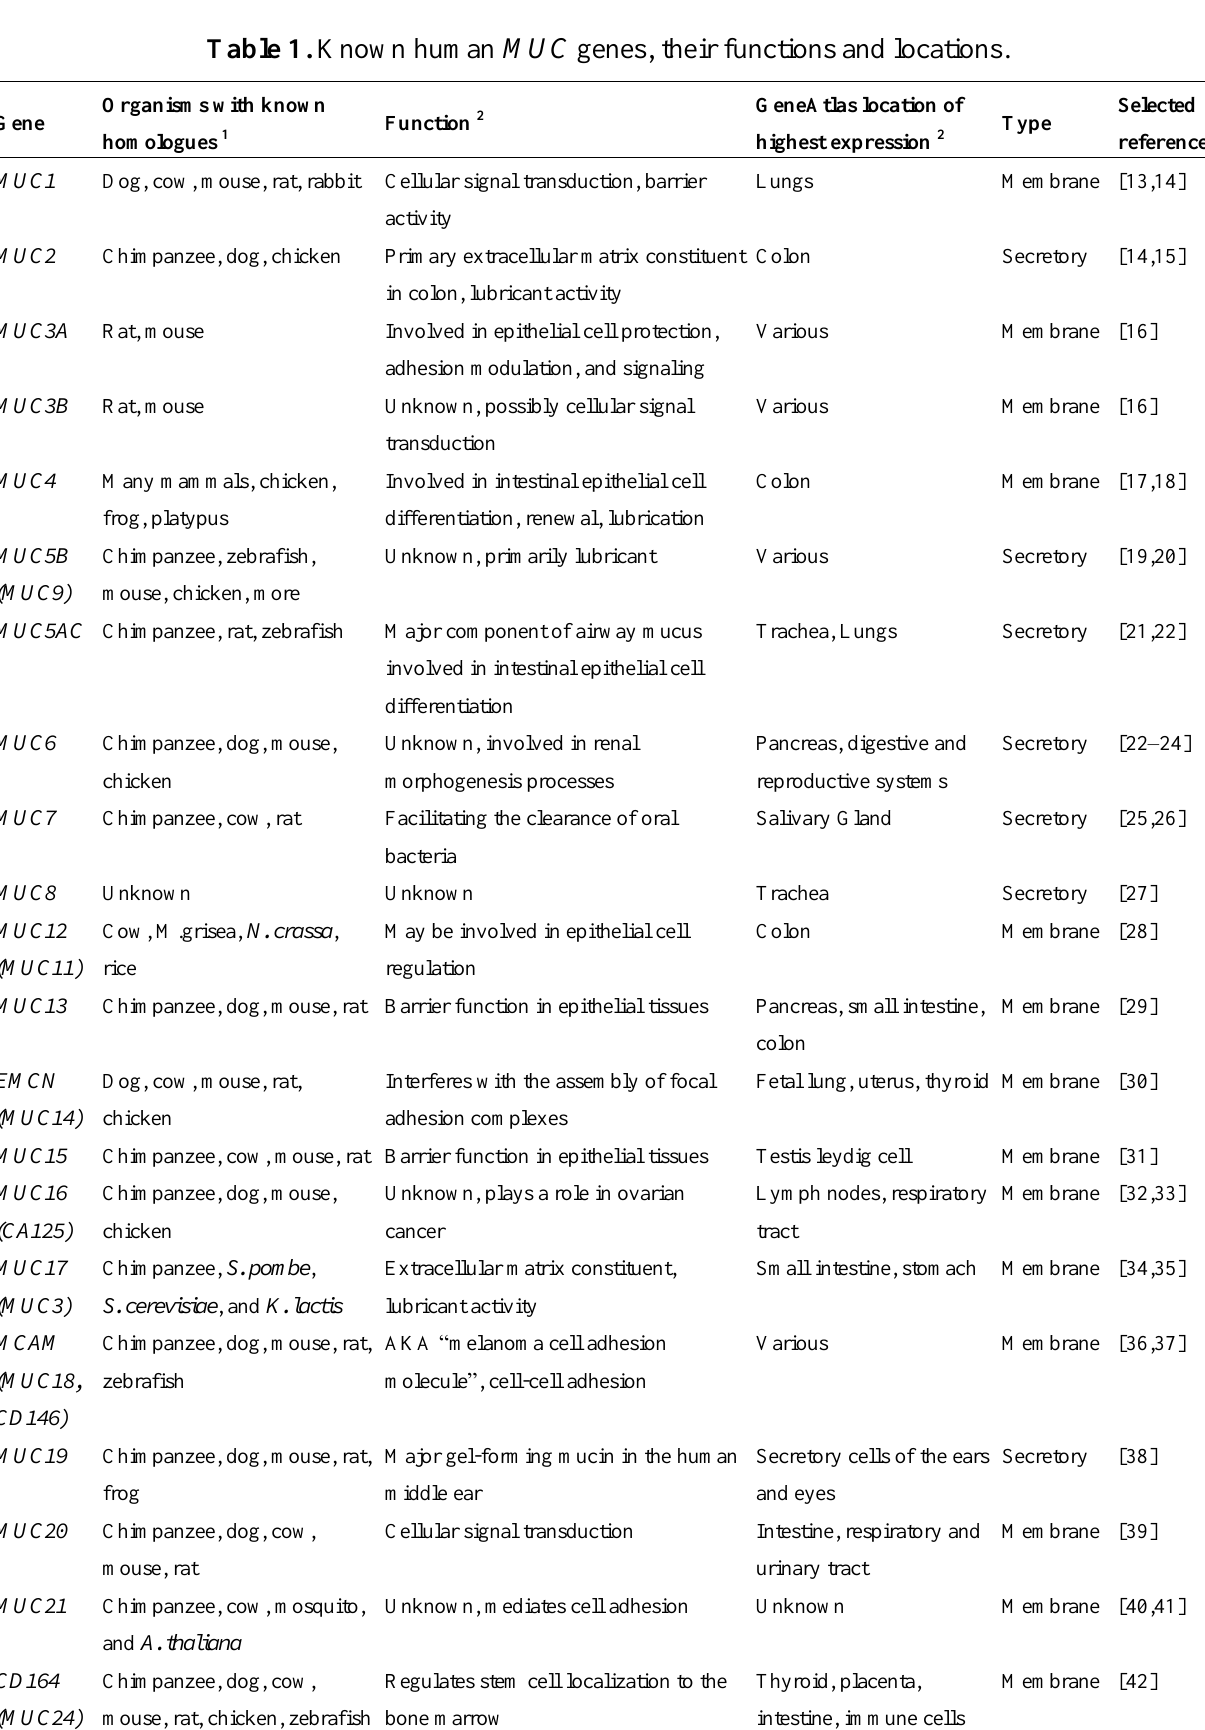
Table 1. Known human MUC genes, their functions and